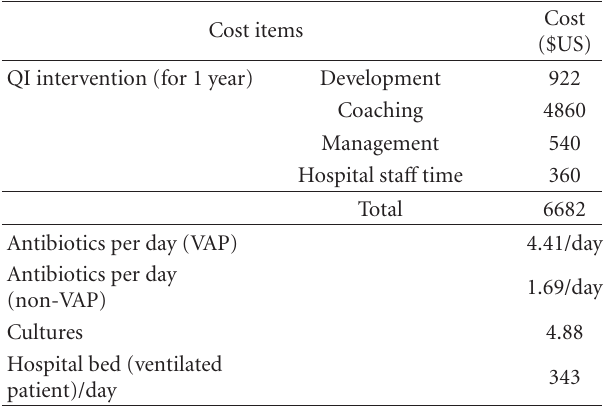
Table 1: Costs of the QI intervention and ICU